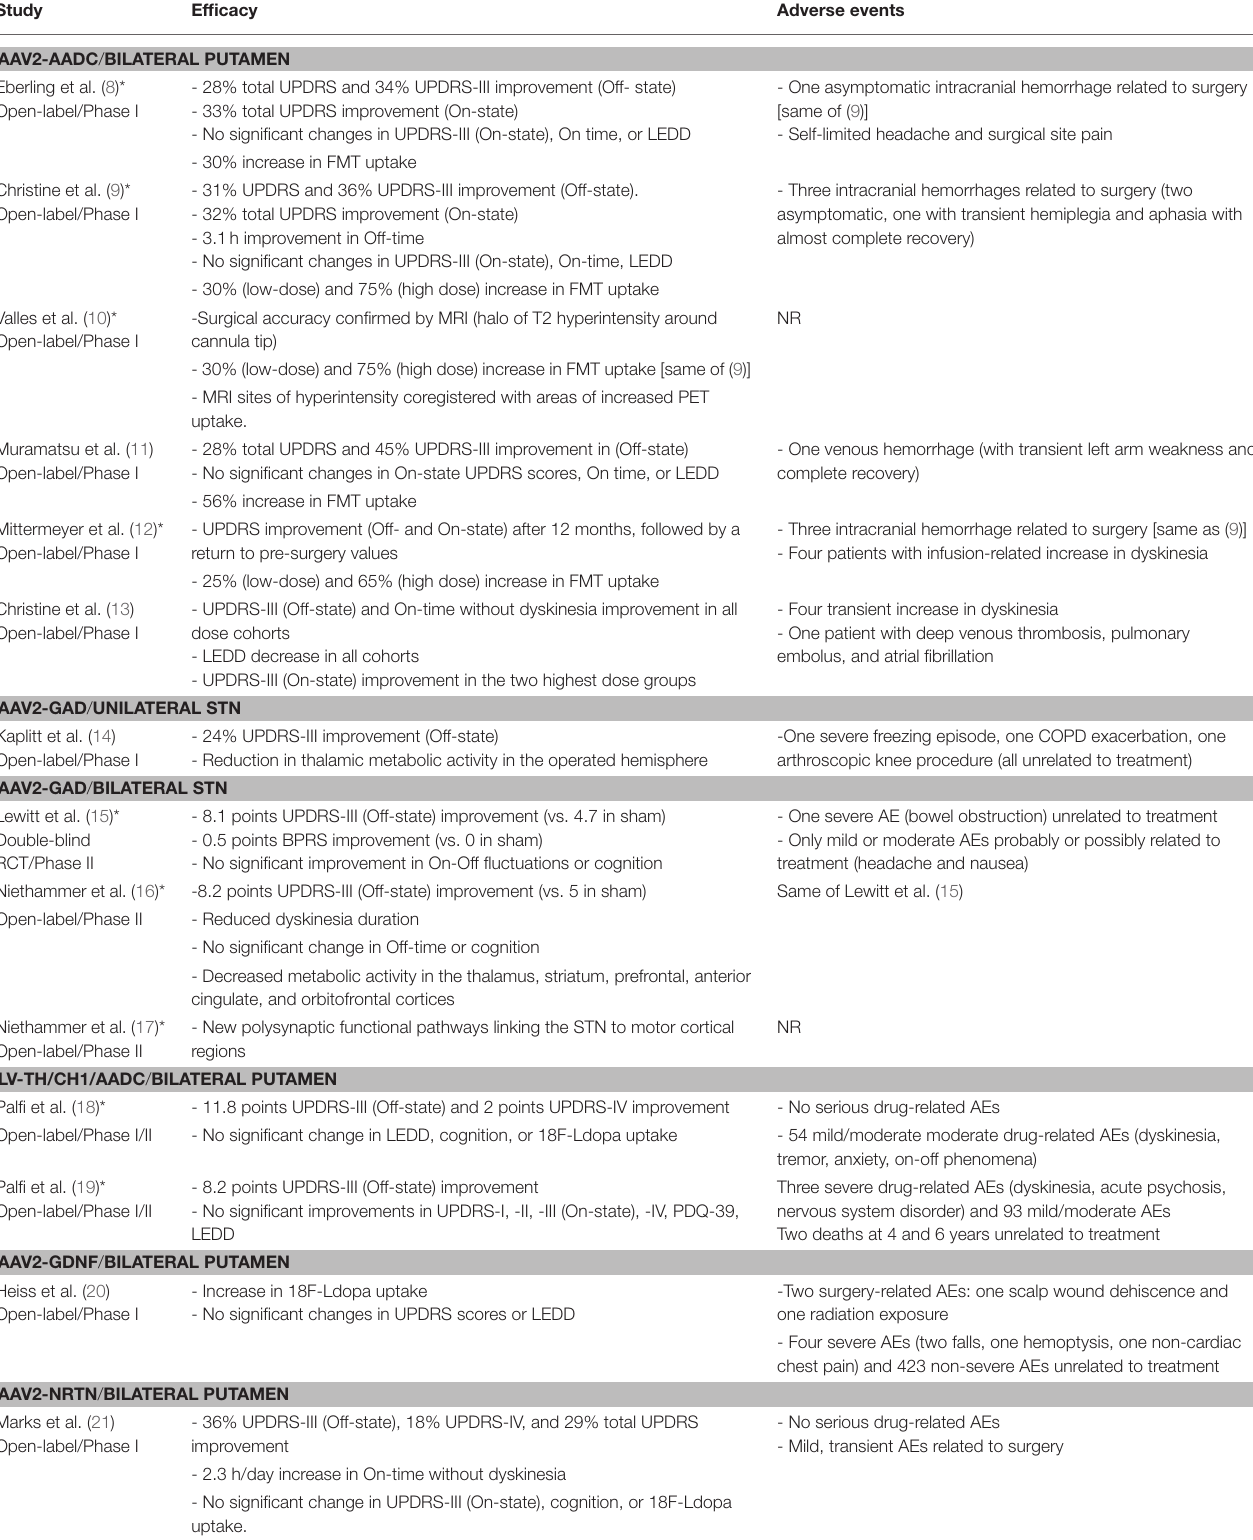
TABLE 4 | Reviewed articles—efficacy and safety—Parkinson disease. Study Efficacy Adverse